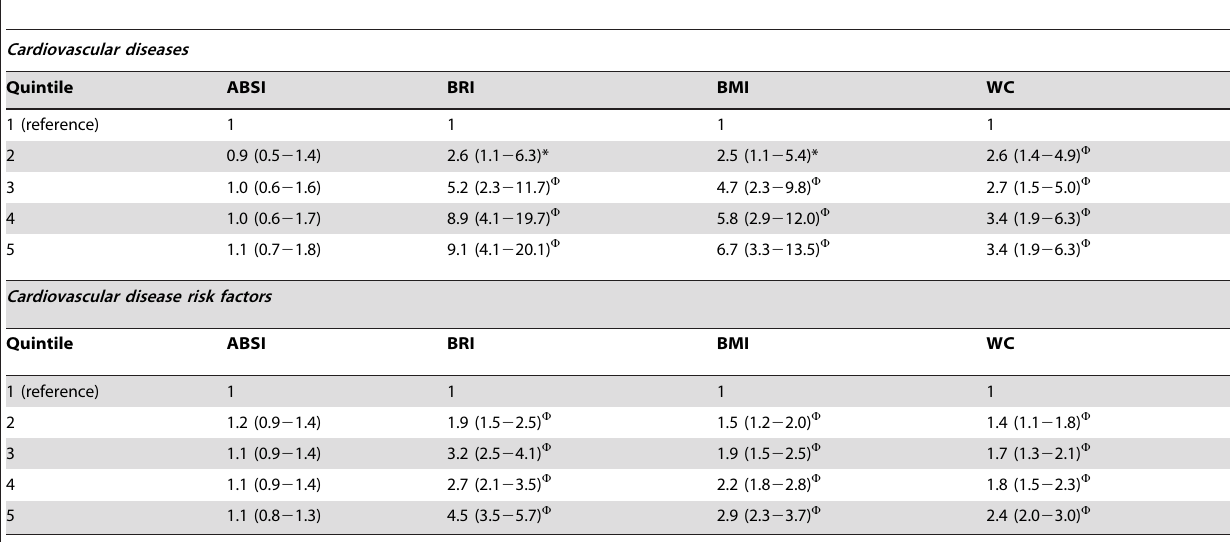
Table 4. The unadjusted odds of CVD and CVD risk factor prevalence for ABSI, BRI, BMI, and WC.